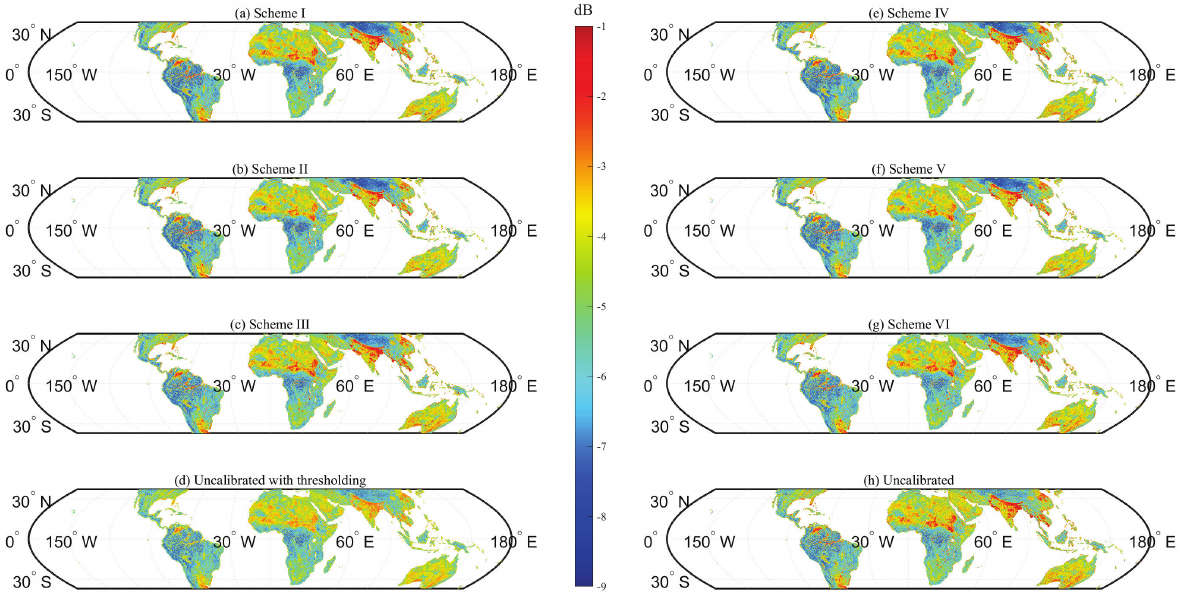
Figure 3. Illustration of Γ for August 2020 with/without calibration: ( a ) Scheme I, ( b ) Scheme II, ( c ) Scheme III, ( d ) uncalibrated with thresholding, ( e ) Scheme IV, ( f ) Scheme V, ( g ) Scheme VI, and ( h )